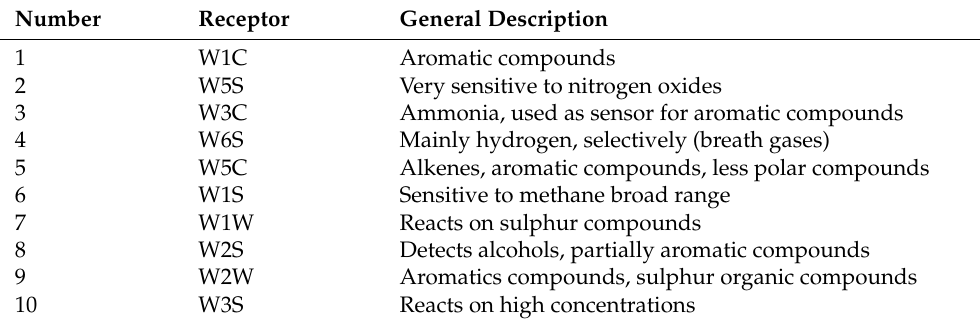
Table 1. Performance characteristics of E-Nose